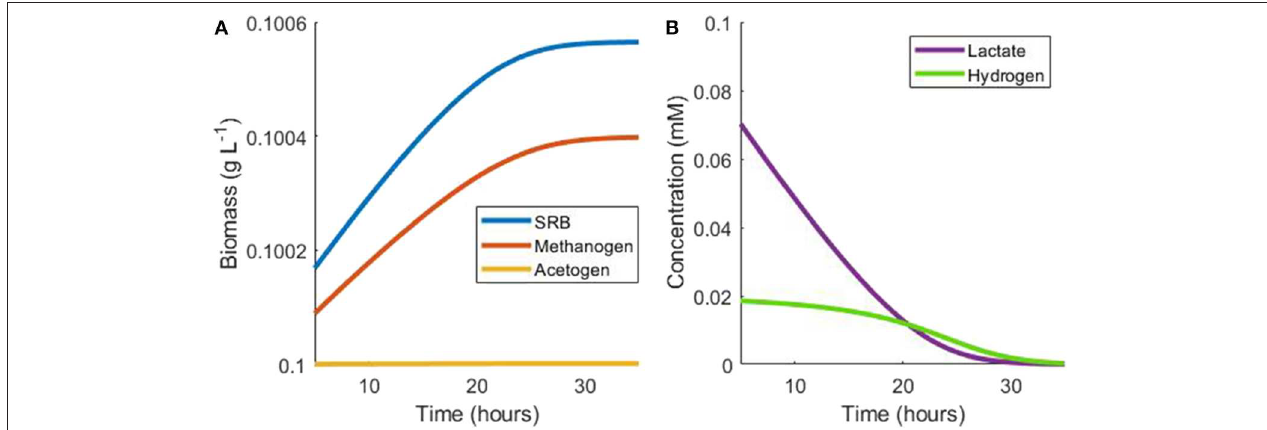
FIGURE 3 | Example simulation of late stages of batch tri-culture with lactate the sole added substrate. (A) Shows the change in microbial biomass over time and (B) shows the change in hydrogen and lactate concentrations over time. As lactate is depleted, hydrogen production ceases and ultimately both lactate and hydrogen are depleted by the SRB and the methanogen, respectively.